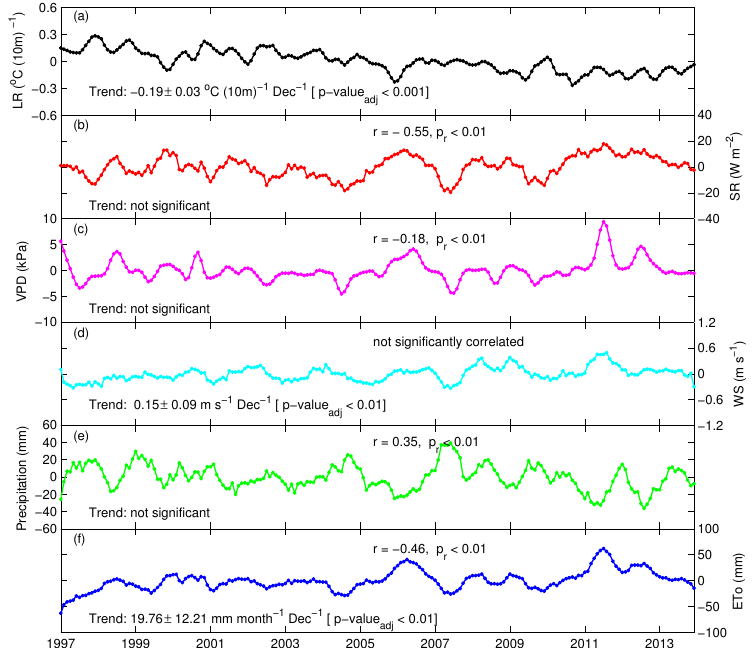
Figure 9. Monthly smoothed anomaly time series over 1997–2013 of (a) lapse rate (LR, ◦ C (10m) − 1 ) , (b) solar radiation (SR, Wm − 2 ) , ( c ) water vapor pressure deficit (VPD, kPa), (d) mean wind speed (WS, ms − 1 ) , (e) precipitation (mm), and ( f ) reference evapotranspiration (ET o , mmmonth − 1 ) . The p value adj is p values in the trend analysis, p r values are p values given in the correlation analysis, and r correlation coefficients with the lapse rate time series. All time series are 7-month moving averages (used as a smoother) of the original monthly data, which were expressed as a departure from the 1997 to 2013 average. The significant trends or correlations are indicated by specified p values but non-significant trends were evaluated at the 95% confidence